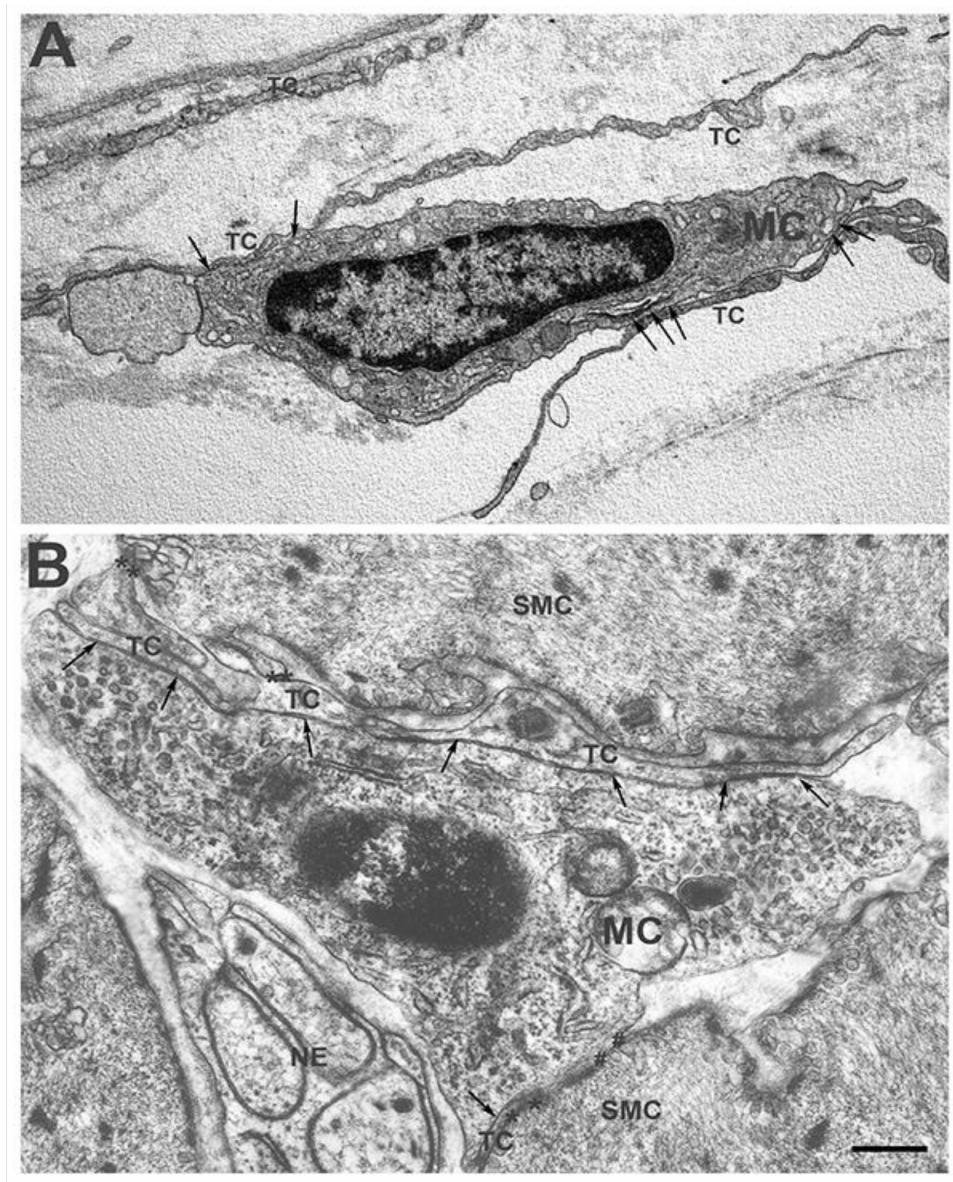
Figure 1. Transmission electron microscope. Human stomach. ( A ) Submucosa. Some TCs border an MC with their long processes. Both TCs make extended contact with the MC with their thin processes (arrows). ( B ) Muscularis externa—Some TCs processes make extended contact with an MC (arrows) and with the SMCs (asterisks). The MC also makes direct contact with a SMC (hashtags). These images were reproduced from those presented in the paper [28]. Scale bar = 0.6 µ